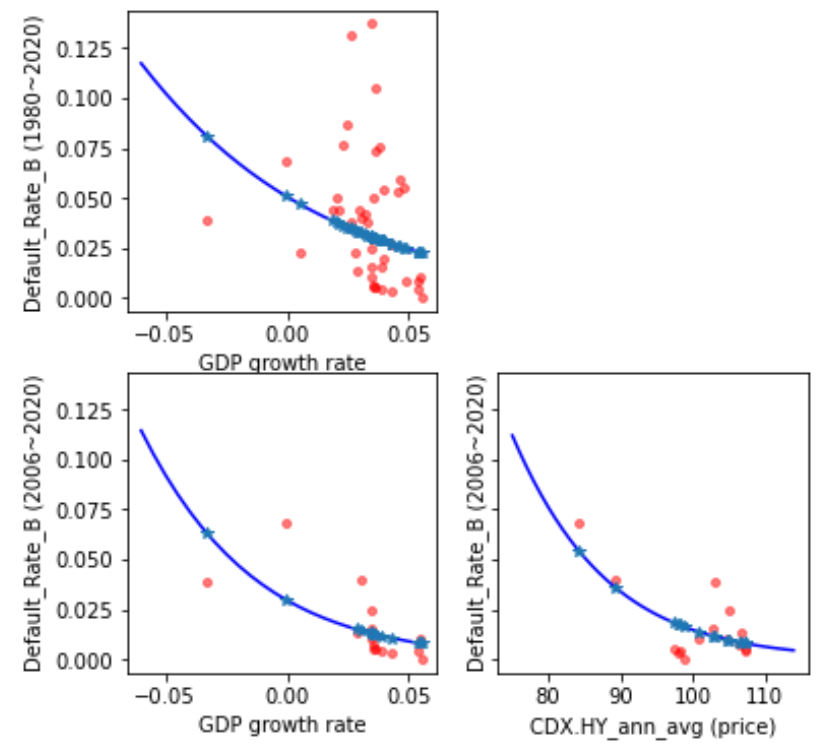
Figure 6. Rating B: logistic regression of DR_B on ( a ) GDP with 1980–2020 data; ( b ) GDP with 2006–2020 data; ( c ) CDX.HY with 2006–2020 data (in price).